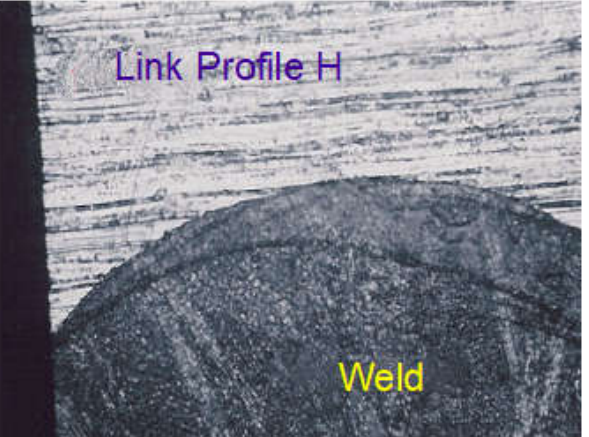
Figure 34. Weld/link and weld/pin interfaces after the Strauss test. Longitudinal surface. Optical examination, magnification 40 × . Link sample #4 and pin sample #3.